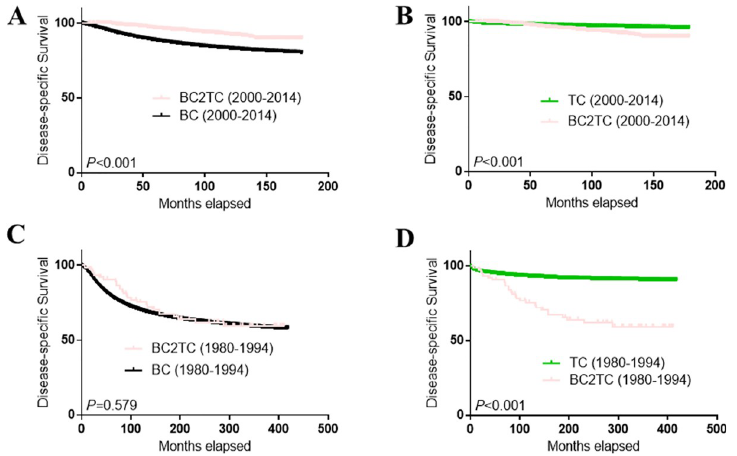
Fig 2. Comparison of DSS among the BC2TC, BC and TC groups. BC vs BC2TC from 2000 to 2014 (A); TC vs BC2TC from 2000 to 2014 (B); BC vs BC2TC from 1980 to 1994 (C); TC vs BC2TC from 1980 to 1994 (D).